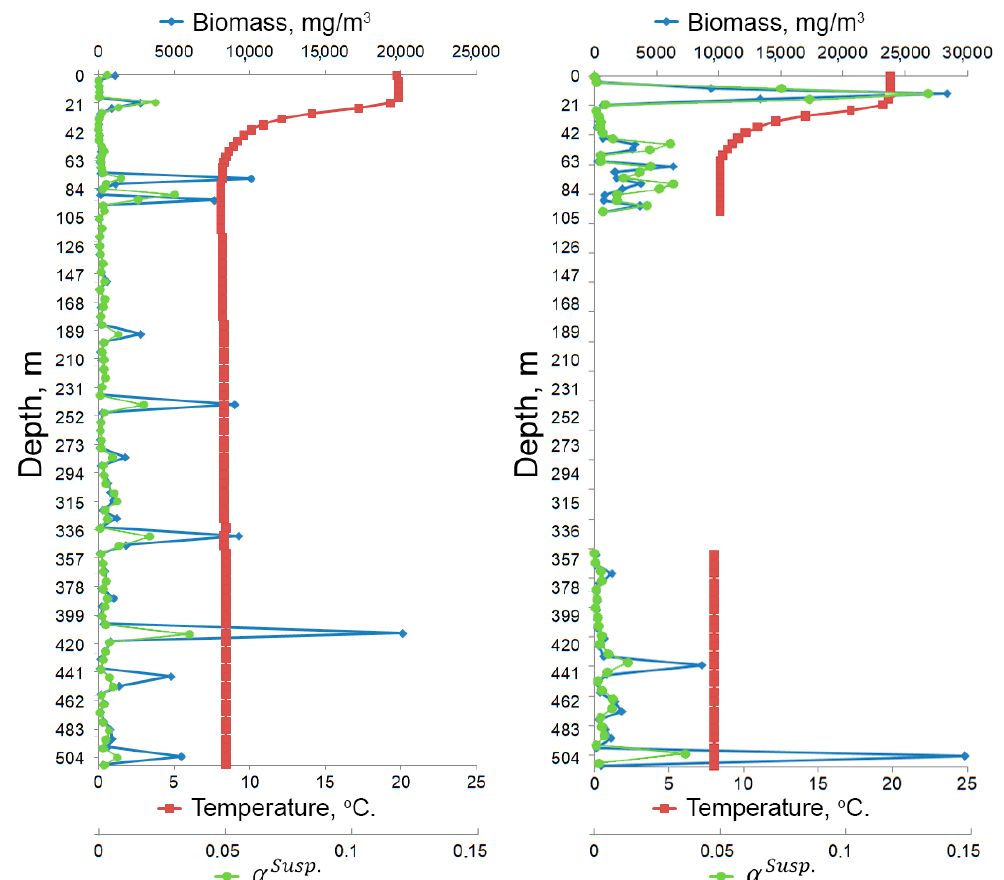
Figure 7. Example of background data represented by depth profiles. Sailing of Ashamba research vessel to the Black Sea on 16 October 2019, station No. 6 with coordinates 44 ◦ 31.2398 (cid:48) N 37 ◦ 54.3828 (cid:48) E, submersion up to 500 m: green graph—average turbidity-total fraction of the sectional area volume shielded by particle sections associated with the suspension taxon ( α Susp . ); red—water temperature; blue—average biomass of particles. ( a ) In forward motion (submersion); ( b ) In backward motion (lifting), in key